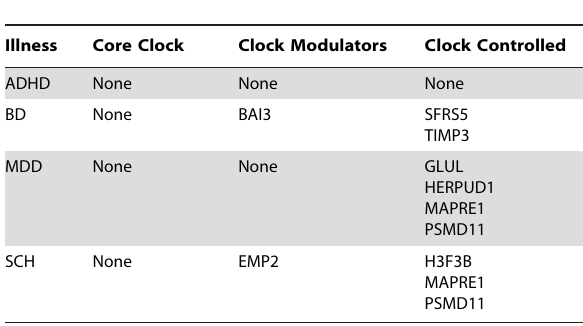
Table 5. Summary of the extended clock gene set included in the overlap between BD-spectrum and lithium induction after FDR